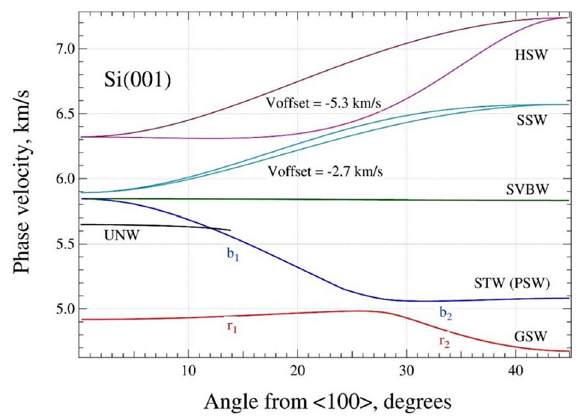
Figure 1. Acoustic wave phase velocities ν vs θ . (graph created using a software IGOR version 6.34A, https :// www.wavem etric s.com/produ cts/igorp